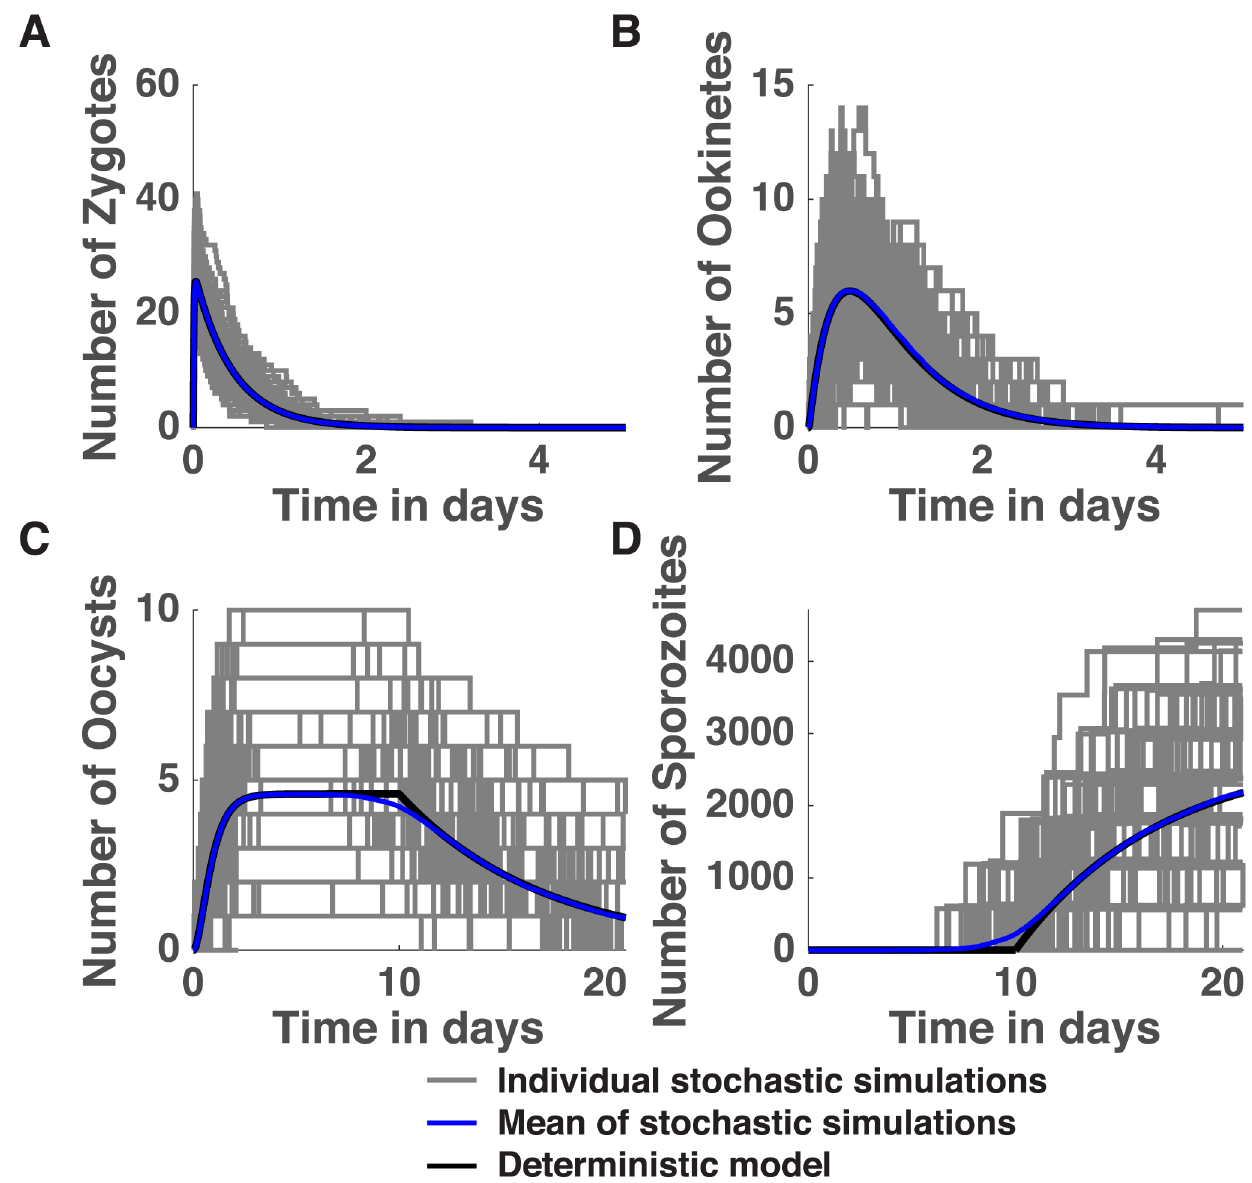
Fig 1. Dynamicsof the within-vector model. The temporaldynamics of the deterministic model (black line) and the averagedynamics across 1000 stochastic simulations (blue curve) overlays 100 simulations of the single-parasite populationCTMC model (gray lines) with initial gametocyte number G 0 = 300 for zygotes (A), ookinetes(B), oocysts (C) and sporozoites (D). Observe that not all simulations producea positive number of sporozoites. In fact, out of 10,000 simulations, 2.58% produceno sporozoites.